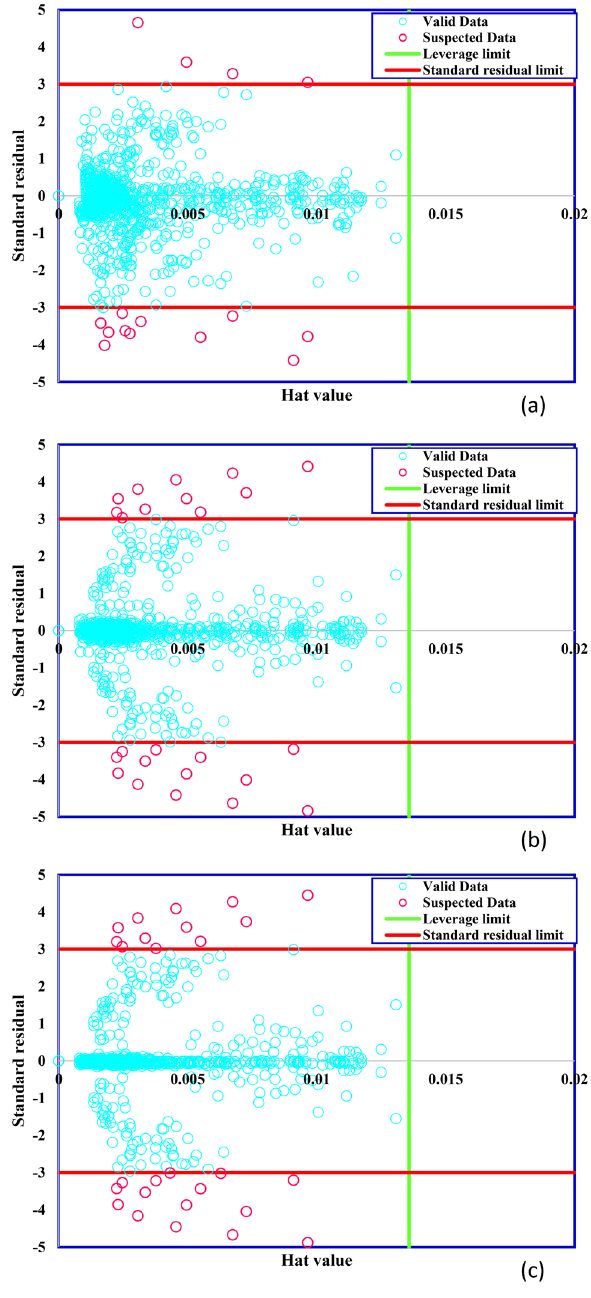
Figure 7. Suspicious data detection based on Hat value results applying ( a ) GA-LSSVM, ( b ) ICA-LSSVM, and ( c )